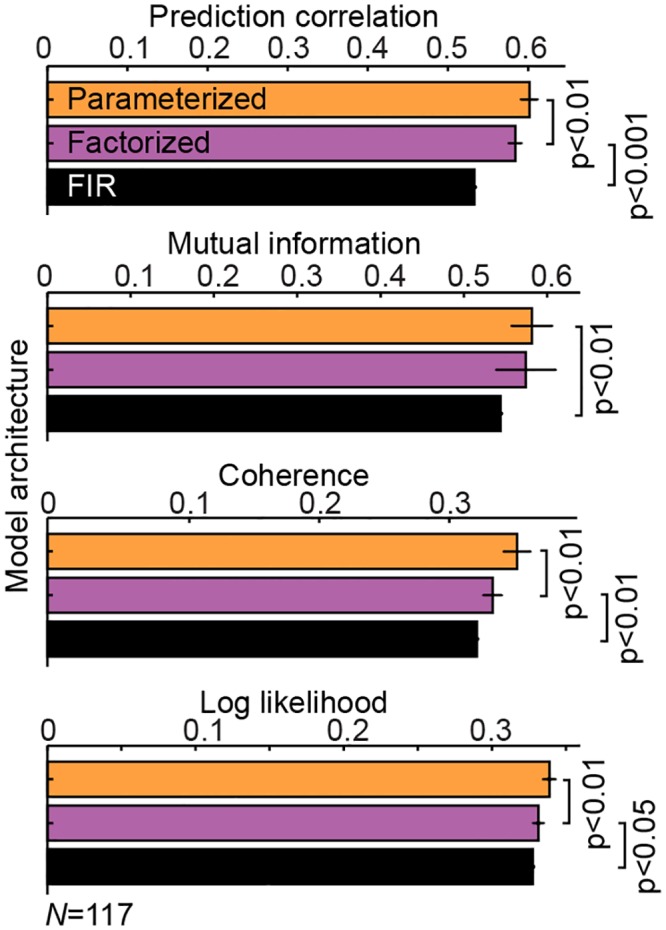
Different performance metrics yield the same model ranking.Average performance of the FIR, factorized and parameterized models evaluated using four different metrics of prediction accuracy. All four metrics produce the same rankings of relative model performance. Data are shown for N = 117 neurons with SNR > 0.01 because some performance metrics were susceptible to noise for low-SNR neurons.